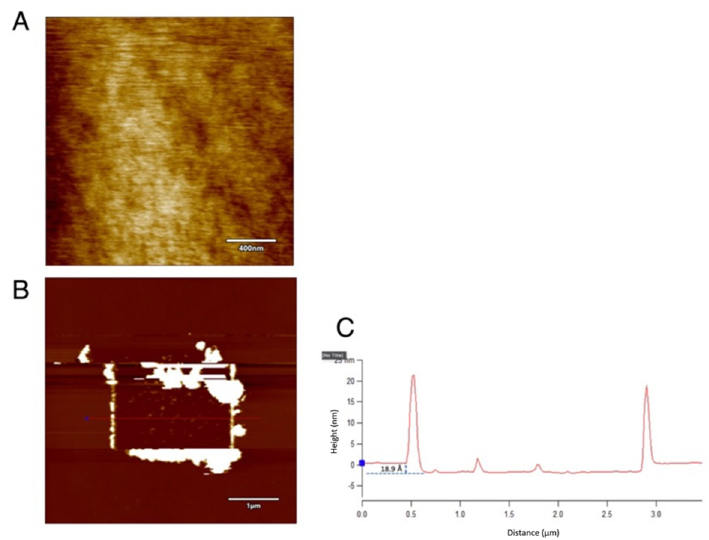
Figure 5. The contact mode scanning over silicon surface using single crystal diamond tip: ( A ) The polished 2 × 2 μ m area by contact mode scanning with a force of 2 μ N. ( B ) The accumulation of debris on the sides and the ( C ) the line profile showing a depression of 1.89 nm. Tip bias: 0 V and RH ~75%.